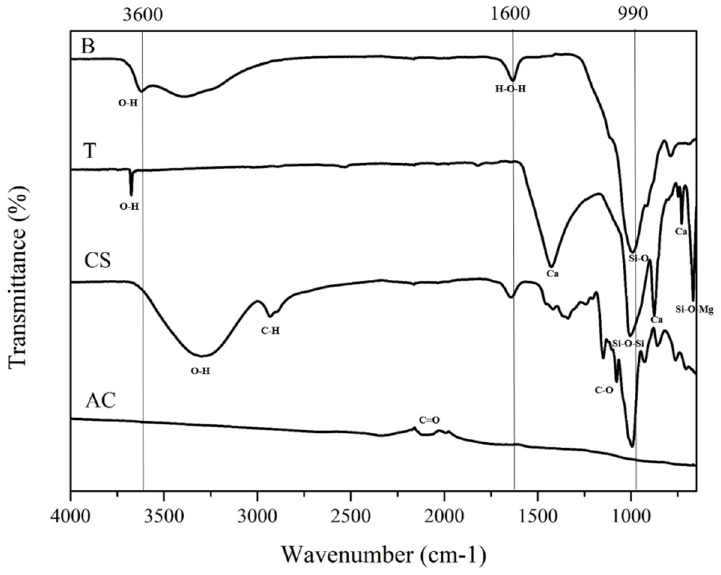
Figure 2. Fourier transform infrared spectroscopy (FT-IR) of various amendments applied to the soil (B: bentonite, T: talc, AC: activated carbon, CS: cornstarch).